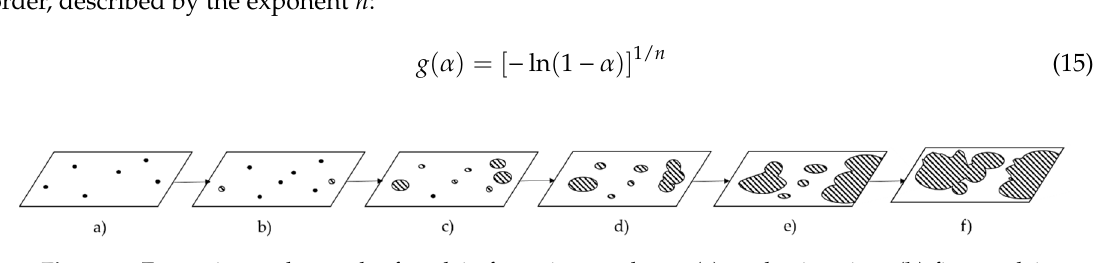
Figure 3. Formation and growth of nuclei of reaction products: ( a ) nucleation sites; ( b ) first nuclei formed; ( c ) growth and further nucleation; ( d ) overlap of nuclei; ( e ) ingestion of a nucleation site; ( f ) continued growth [1].